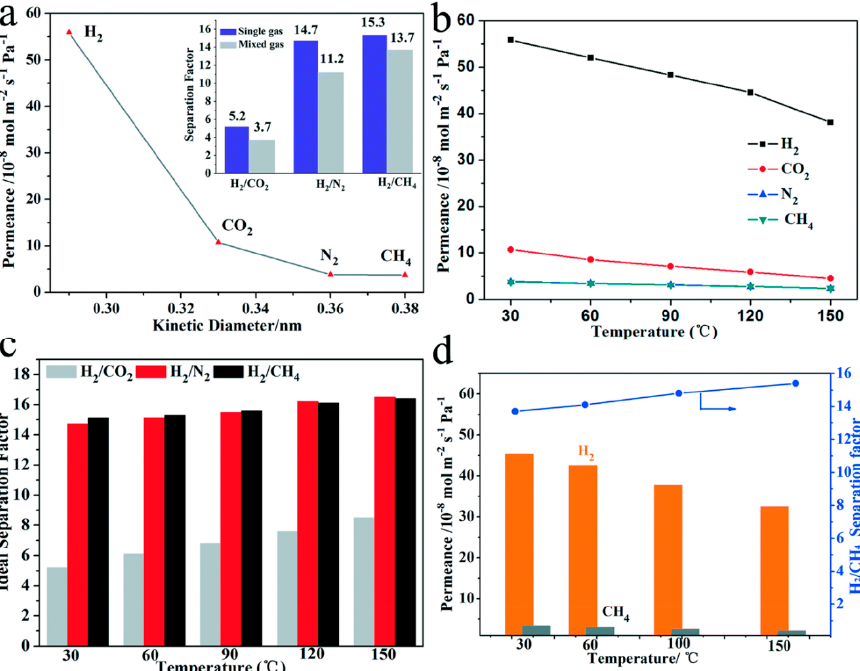
Figure 24. ( a ) Single gas permeabilities through the prepared ZIF-67 membrane measured at 30 °C and 0.1 MPa. The inset shows the separation factors of H 2 relative to the other gases in both the single gas and equimolar mixed gas permeation tests. ( b ) Single gas permeances at elevated temperature. ( c ) Ideal separation factors of H 2 over CO 2 (gray), N 2 (red) and CH 4 (black) at different temperatures. ( d ) H 2 /CH 4 mixture separation as a function of temperature. (adapted with permission from ref. [81]).